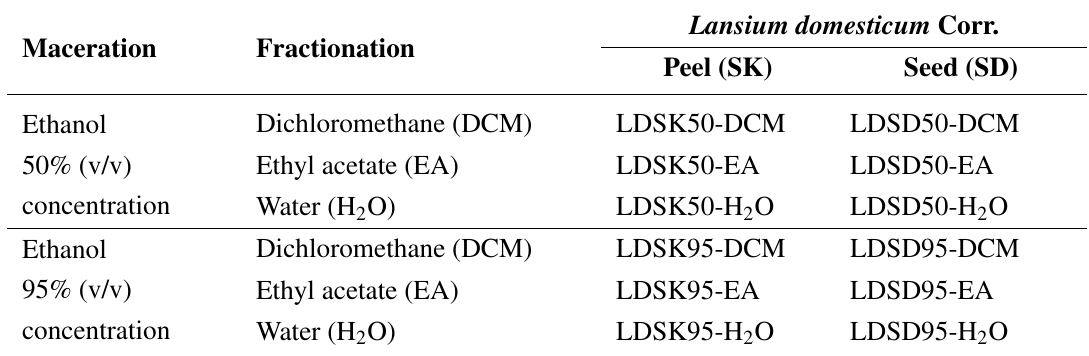
Table 1. Twelve fractions prepared from the peel and seeds of L. domesticum